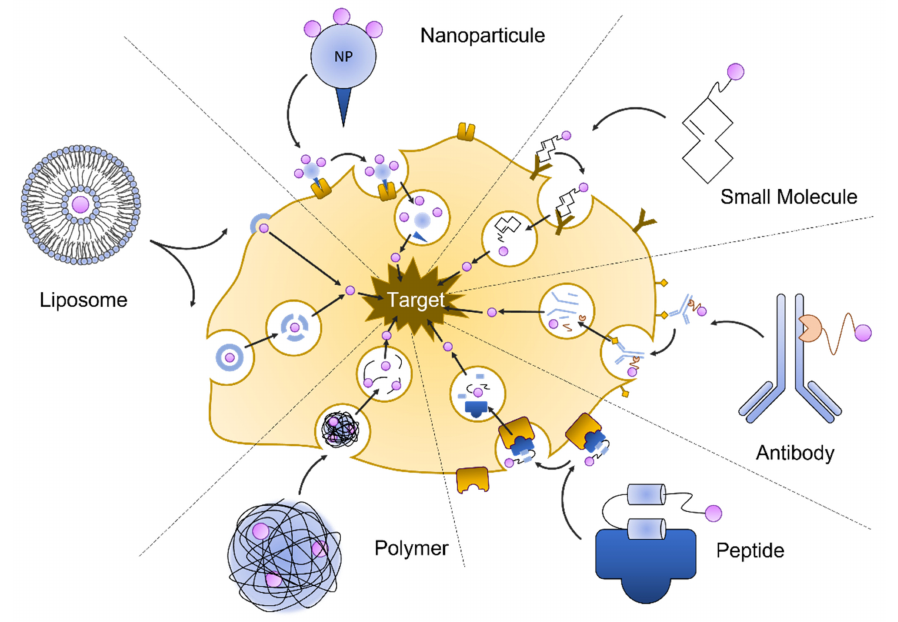
Figure 5. Nanotechnologies for drug